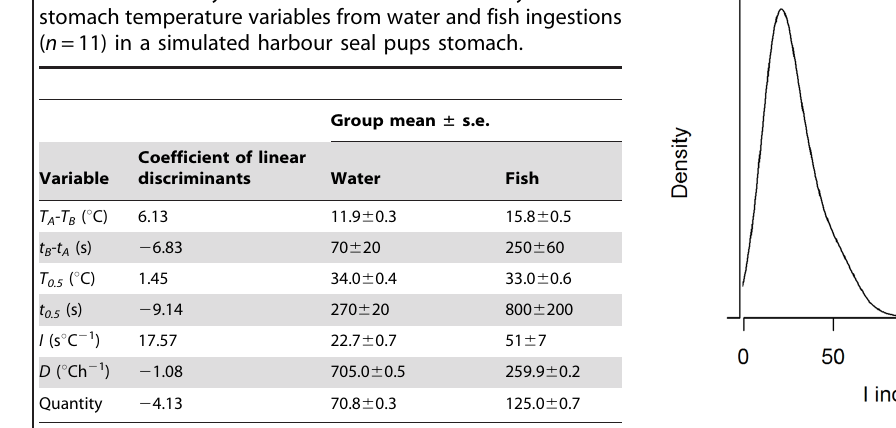
Figure 4. Distribution of the I index of PDER events ( n =190) from groups 2 and 4. When compared to preliminary visual classification, 98.9% of the PDER events having I index values lower than 92.8 s u C 2 1 had been deemed seawater ingestions, while 92.3% of the PDER events with I index values greater than 92.8 s u C 2 1 had been deemed solid food ingestions.